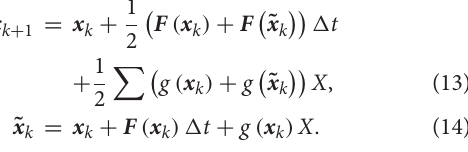
TABLE 3 | Cartesian coordinates of the dipoles used throughout the study. x y z dipole 1 0.1688 0.2242 0.2597 –0.8520 –0.2242